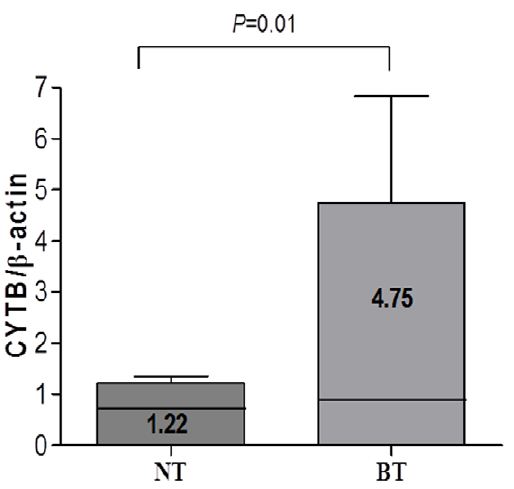
Figure 4. Production of high level of reactive oxygen species in Barrett’s metaplasia tissue. Quantitative determination of reactive oxygen species (hydrogen peroxide) from supernatants of Barrett’s metaplasia tissue (BT) and adjacent normal mucosal tissue (NT) was measured by commercial kit (Bioxytech H 2 O 2 -560). The level of hydrogen peroxide was significantly elevated in supernatants from BT compared with those from adjacent NT ( P =0.017).